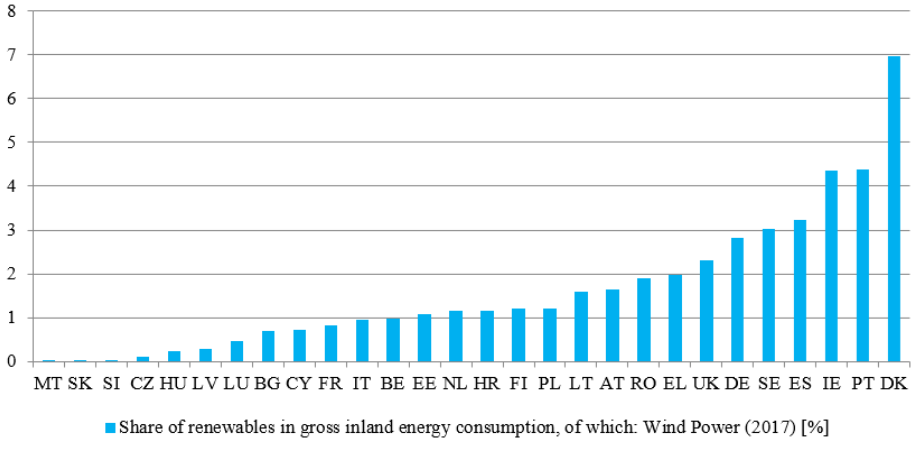
Figure 4. Share of renewables (wind energy) in the gross inland energy consumption (2017) [%]. For all the features analyzed, their distribution is characterized by right-sided asymmetry, which means that most EU countries achieve the value of the studied indicators below the global average.